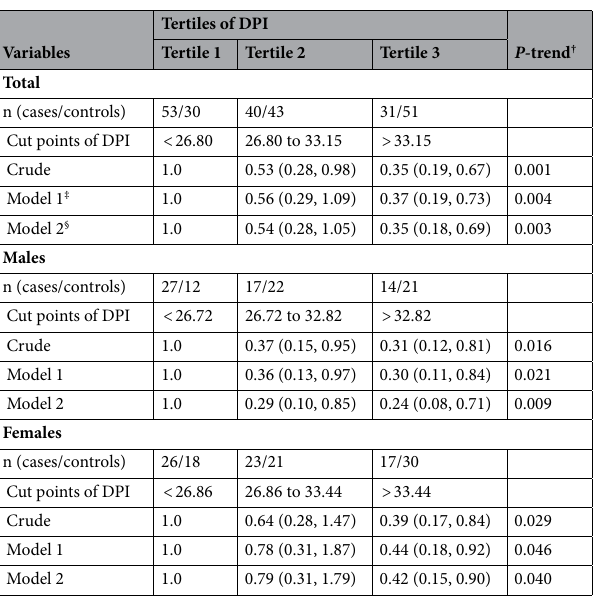
Table 3. Crude and multivariable-adjusted odds ratios (95%CIs) for knee osteoarthritis across the tertiles of dietary phytochemical index (DPI). DPI dietary phytochemical index. † Obtained from the Mantel–Hanszel extension test. ‡ Adjusted for age, sex, physical activity, smoking and supplement use. § Further adjuster for